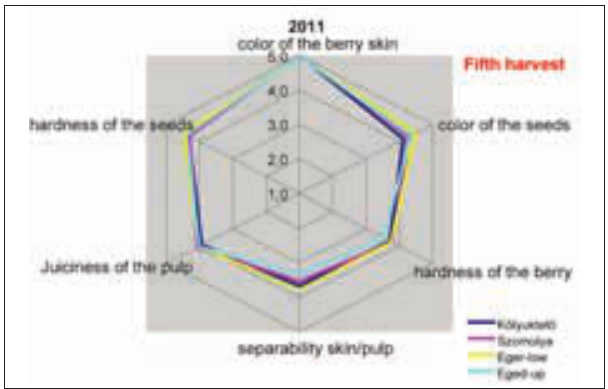
Figure 3 e: Main physical parameters of the berry (2011-Fifth harvest